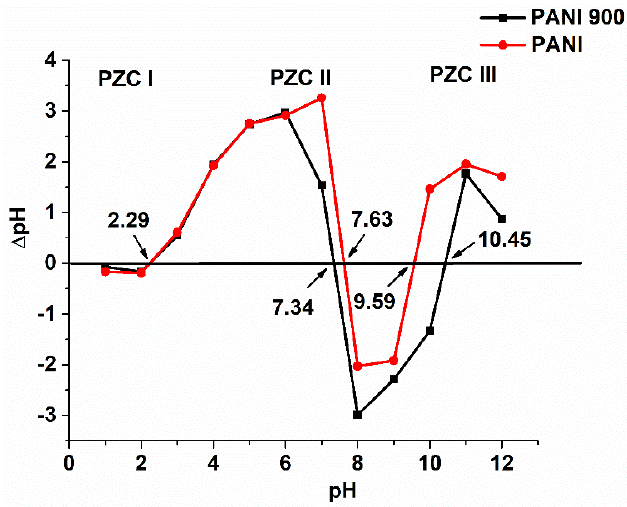
Figure 5. Points of zero charge for the prepared catalysts.